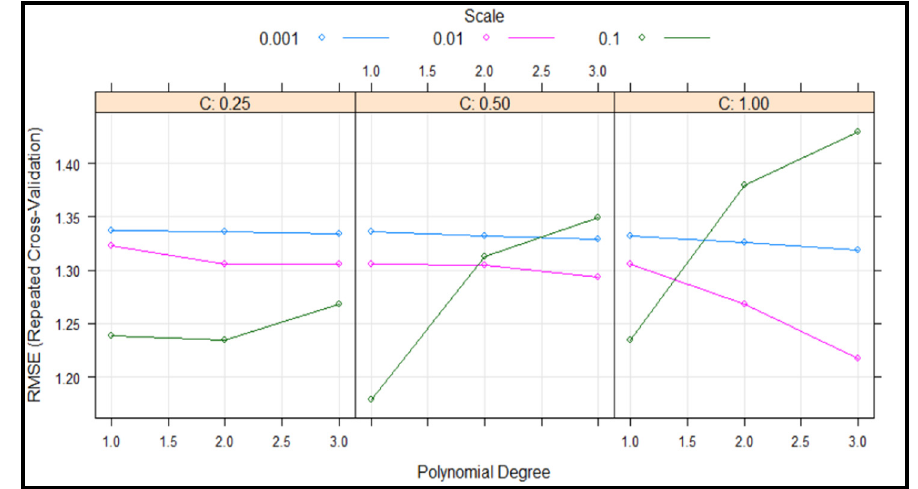
Figure 11. Root mean square error (RMSE) value for different cost value.